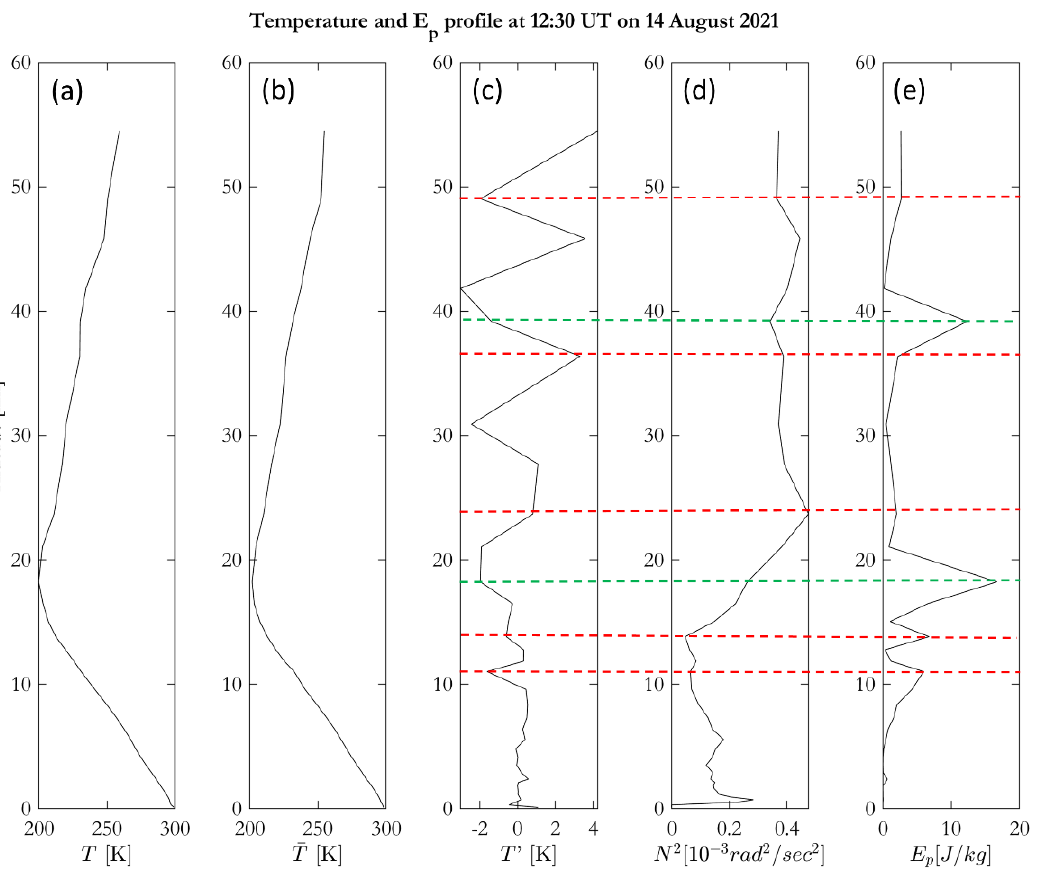
Figure 2. Co-seismic vertical profiles of: ( a ) temperature; ( b ) background temperature; ( c ) temperature deviation; ( d ) square of the Brunt–Väisälä frequency; and ( e ) potential energy at 12:30 UT on 14 August 2021. Red horizontal dashed lines represent the identified AGW peaks; from bottom to top, the green horizontal dashed lines identify the tropopause and the stratopause peaks, respectively.